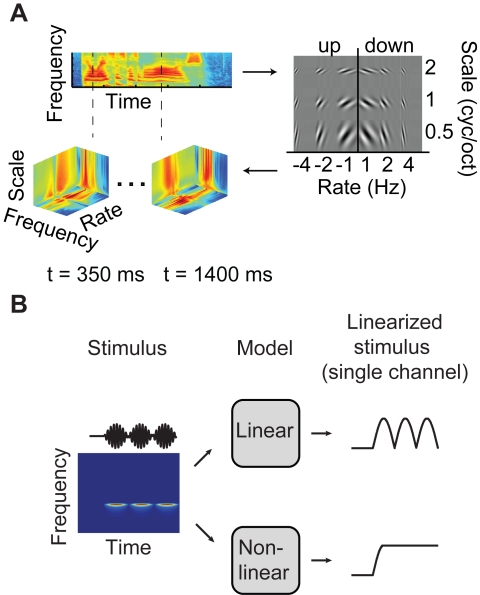
Schematic of nonlinear modulation model.(A) The input spectrogram (top left) is transformed by a linear modulation filter bank (right) followed by a nonlinear magnitude operation (not shown). This nonlinear operation extracts the modulation energy of the incoming spectrogram and generates phase invariance to local fluctuations in the spectrogram envelope. The input representation is the two-dimensional spectrogram S(f,t) across frequency f and time t. The output (bottom left) is the four-dimensional modulation energy representation M(s,r,f,t) across spectral modulation scale s, temporal modulation rate r, frequency f, and time t. In the full modulation representation [18], negative rates by convention correspond to upward frequency sweeps, while positive rates correspond to downward frequency sweeps. Accuracy for positive and negative rates was averaged unless otherwise shown. See Materials and Methods. (B) Schematic of linear (spectrogram envelope) and nonlinear (modulation energy) temporal coding. Left: acoustic waveform (black curve) and spectrogram of a temporally modulated tone. The linear spectrogram model (top) assumes that neural responses are a linear function of the spectrogram envelope (plotted for the tone center frequency channel, top right). In this case, the instantaneous output may be high or low and does not directly indicate the modulation rate of the envelope. The nonlinear modulation model (bottom) assumes that neural responses are a linear function of modulation energy. This is an amplitude-based coding scheme (plotted for the peak modulation channel, bottom right). The nonlinear modulation model explicitly estimates the modulation rate by taking on a constant value for a constant rate [32].